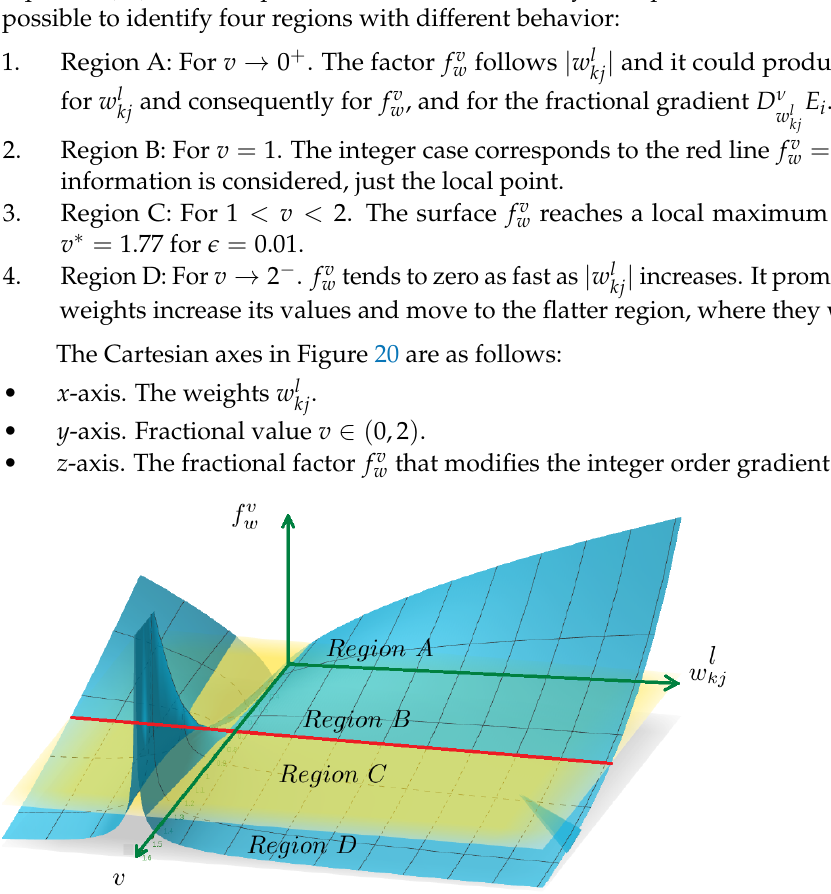
Figure 20. Plot for the fractional factor f v w with (cid:101) = 0.01 In Figure 20 there is a yellow plane at f v integer